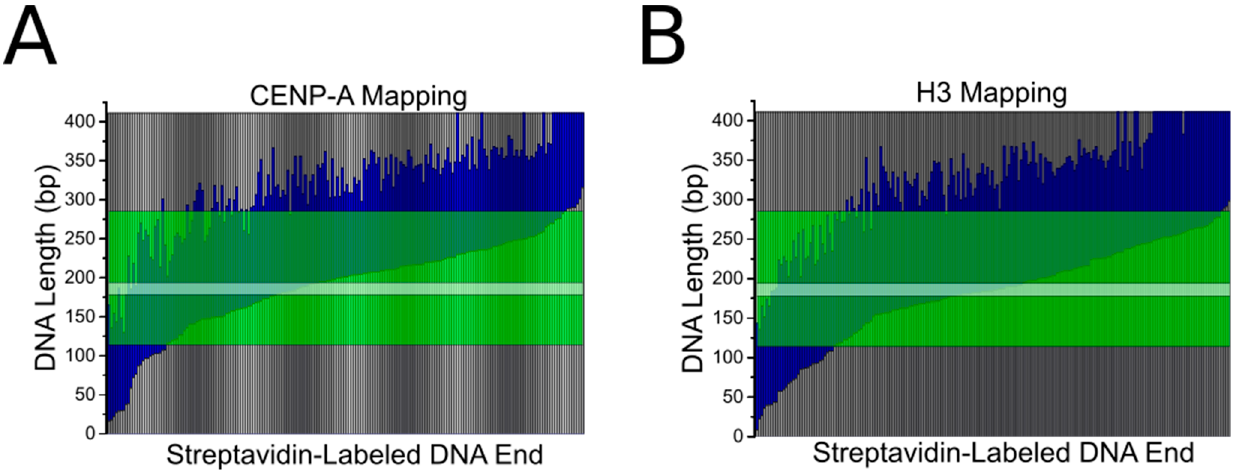
Figure 4. Mapping of CENP-A ( A ) and H3 ( B ) nucleosome position along the α -satellite DNA sub- strate. Gray bars represent free DNA flanks. Blue regions indicate DNA wrapped by the nucleosome. The transparent green region indicates the α -satellite motif. The transparent white bar indicates the position of the CENP-B box within the α -satellite motif. Nucleosome position is organized by smallest to greatest distance from the streptavidin-labeled DNA end.